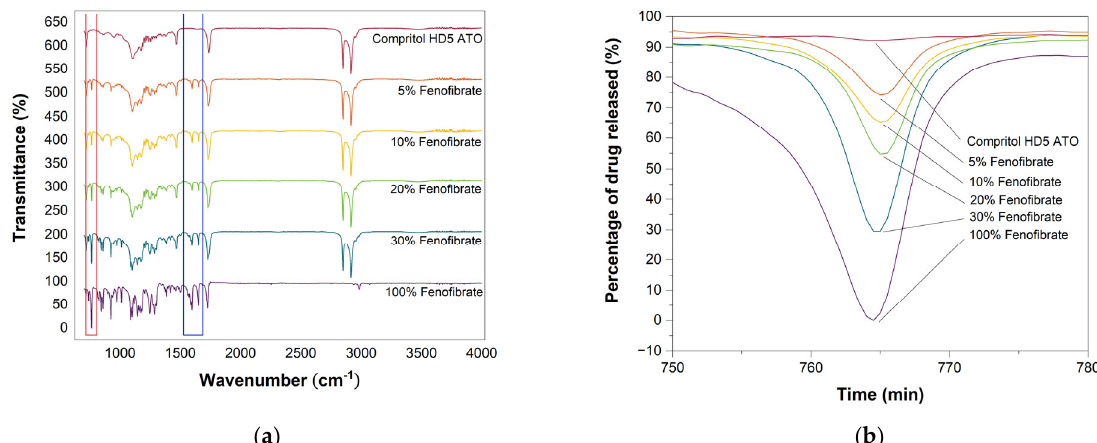
Figure 8. Fourier transform infrared spectroscopy analysis of sustained release tablets of Compritol HD5 ATO and Fenofibrate mixture. ( a ) constant geometry and different drug loading concentration namely 5%, 10%, 20% and 30%. ( b ) Highlight of the 765 cm − 1 C–Cl peak linked to Fenofibrate presence.